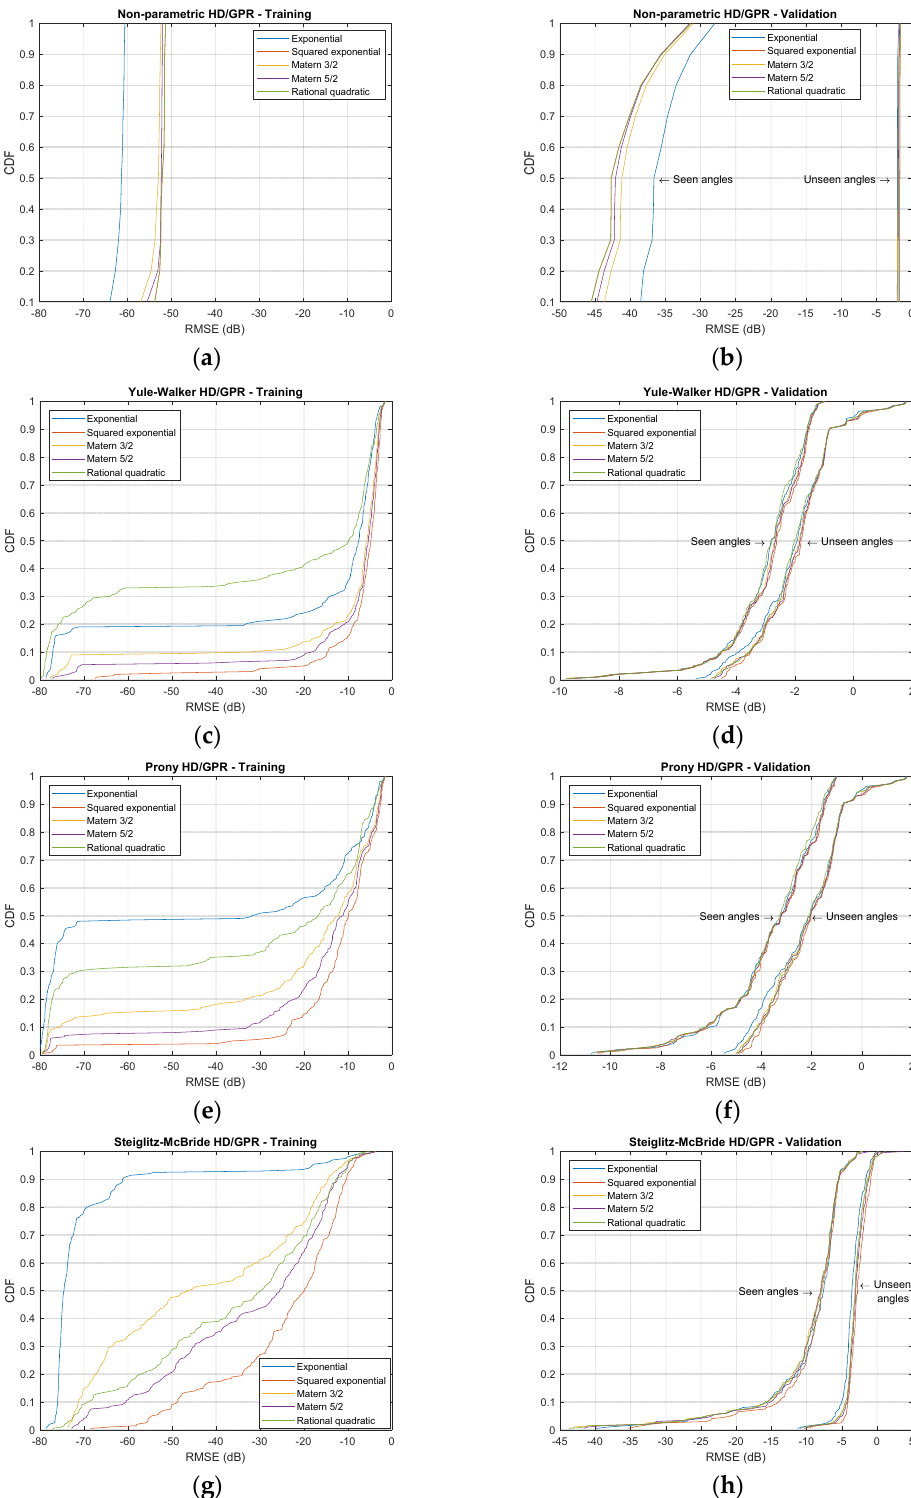
Figure 10. Empirical cumulative distribution function (CDF) distributions for simulated RMSE from GPR kernel functions. (Training: 1998 iterations; validation seen-angle: 3996 iterations; and validation unseen-angle: 3996 iterations.) ( a ) Nonparametric HD/GPR—Training. ( b ) Nonparametric HD/GPR—Validation; ( c ) Yule–Walker HD/GPR—Training; ( d ) Yule–Walker HD/GPR—Validation; ( e ) Prony HD/GPR—Training; ( f ) Prony HD/GPR—Validation; ( g ) Steiglitz–McBride HD/GPR—Training; ( h ) Steiglitz–McBride HD/GPR—Validation.